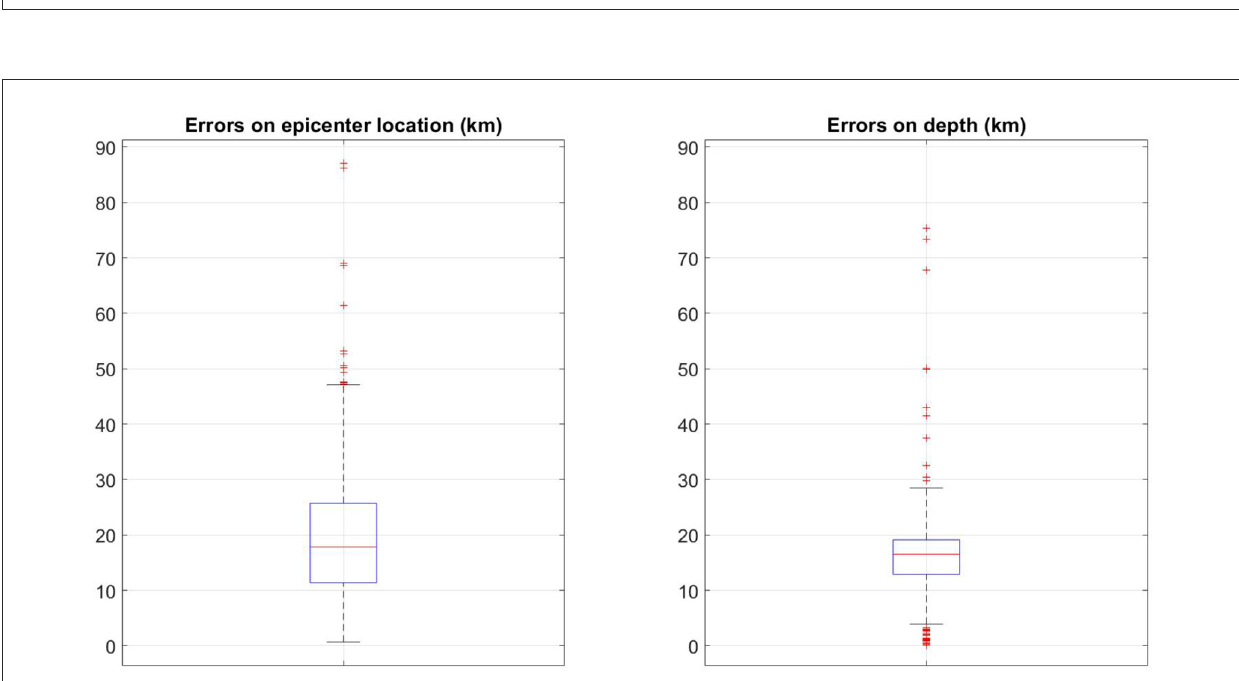
FIGURE4 Box plot of the errors on epicenter location ( lat E , lon E ) (left) and box plot of the errors on earthquake depth d E (right) for the 1,000 simulated true earthquake detections.